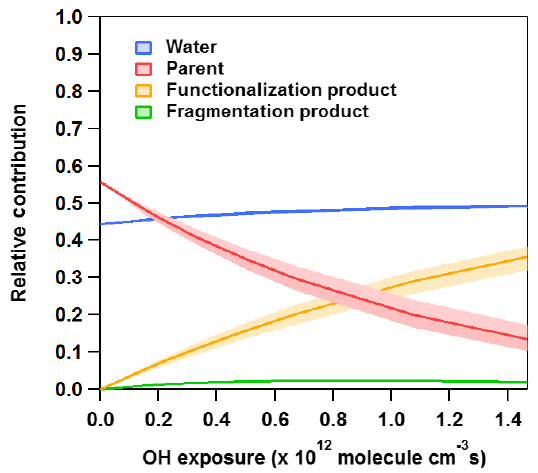
Figure 5. Simulated relative contribution of each species to the par- ticle volume during heterogeneous OH oxidation of the aqueous methylsuccinic acid droplet at 85% RH. The shaded region shows the error of the effective OH uptake coefficient ( γ eff ) measurement in the model simulation.